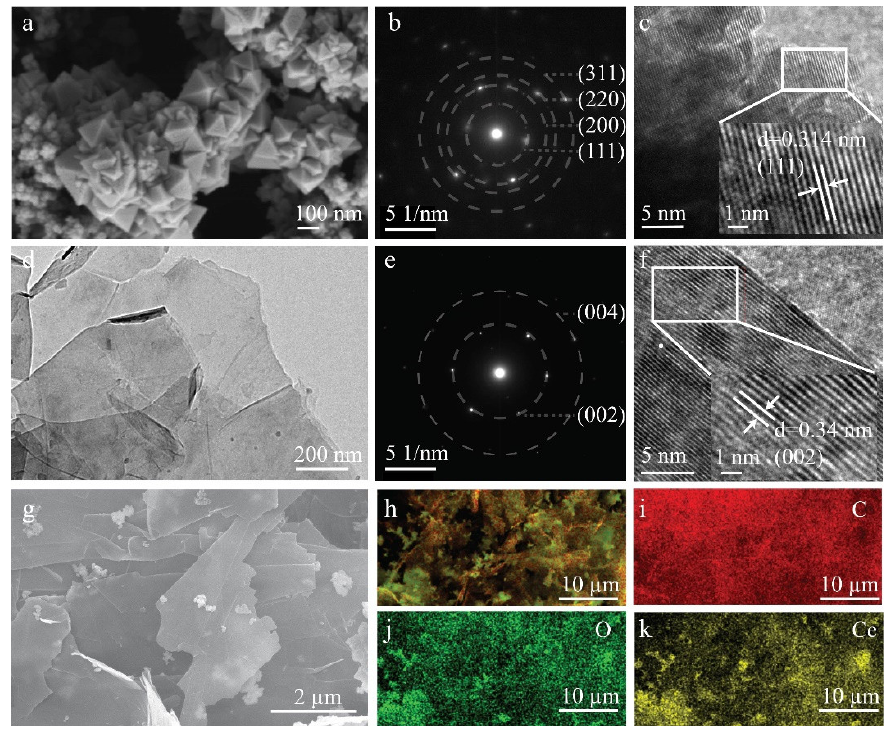
Figure 1. SEM image ( a ), SEAD ( b ) and HRTEM ( c ) of CeO 2 , TEM ( d ), SEAD ( e ) and HRTEM ( f ) of eGr, SEM image ( g ) and corresponding elemental mapping of the selected area ( h ), C ( i ), O ( j ) and Ce ( k ) of CeO 2 /eGr.